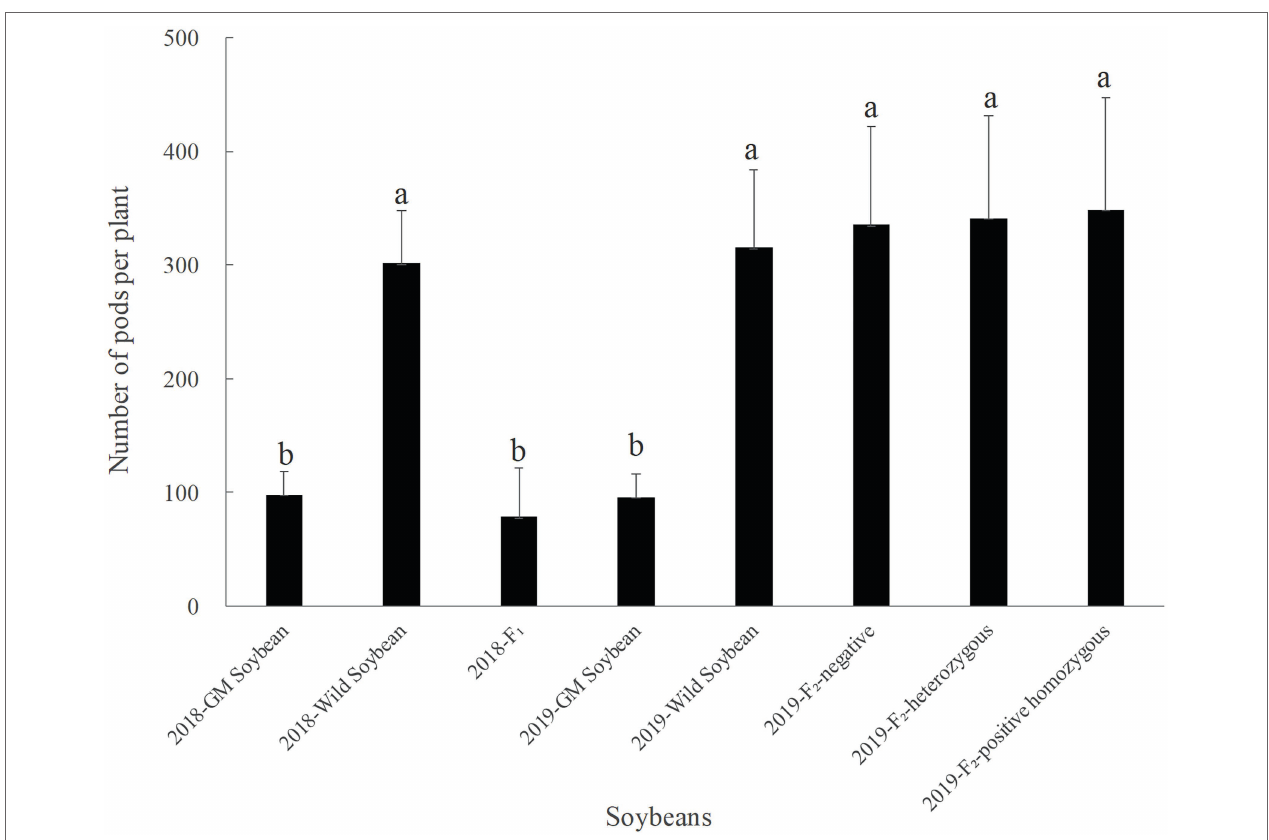
FIGURE 5 | Pods per plant of genetically modified, wild soybeans, and hybrid progenies.